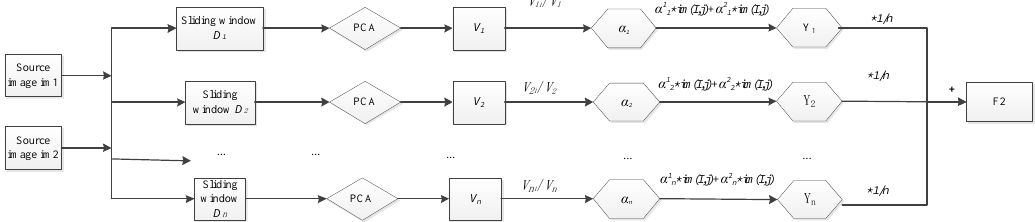
Figure 3. The diagram of the multiscale pixel weighted fusion method based on principal component analysis (PCA).